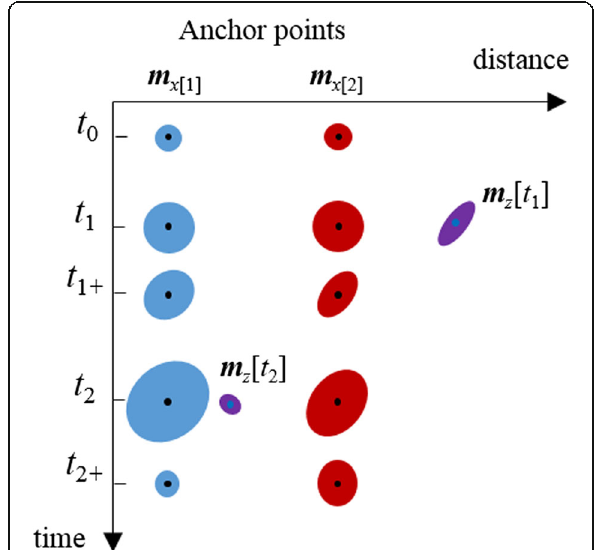
Fig. 5 Two anchor points located mx [1] ( blue ) and mx [2] ( red ) show what happens when new measurements become available over time. Uncertainty in both points are represented by circles and the circles increase and decrease in size with increasing or decreasing uncertainty,